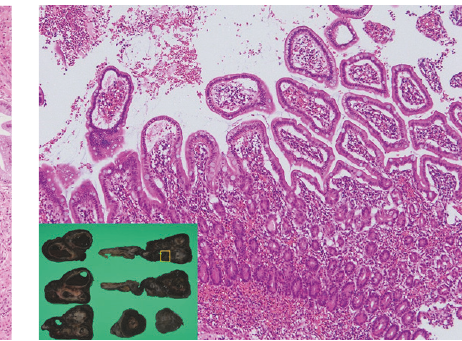
(b) One cyst adjusted to intestine showed the epithe- lium of small